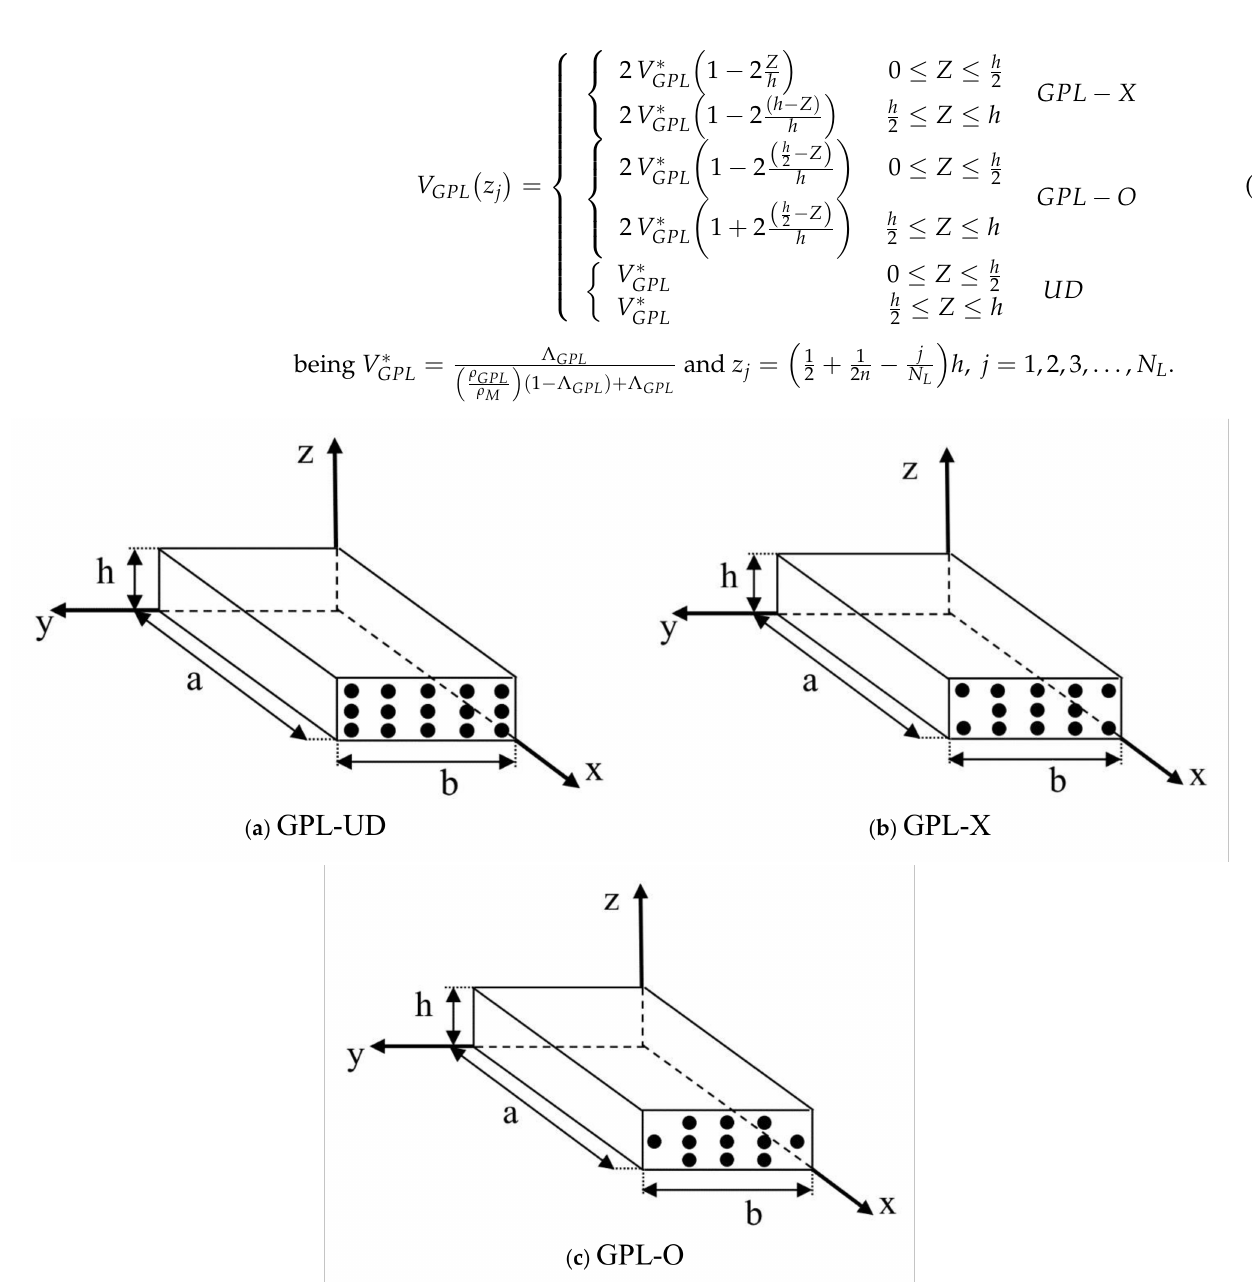
Figure 2. Distribution patterns of GPLs: ( a ) GPL-UD distribution, ( b ) GPL-X distribution, ( c ) GPL-O